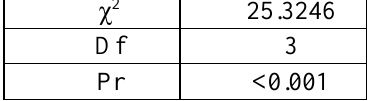
Table 8- Chi-sq test of association between the type of information source preferred by the Government and Private school students